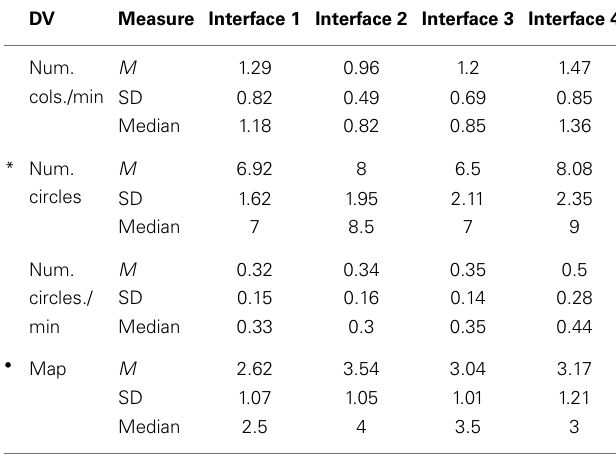
Table 7 | DV results for different interface treatments in study #4